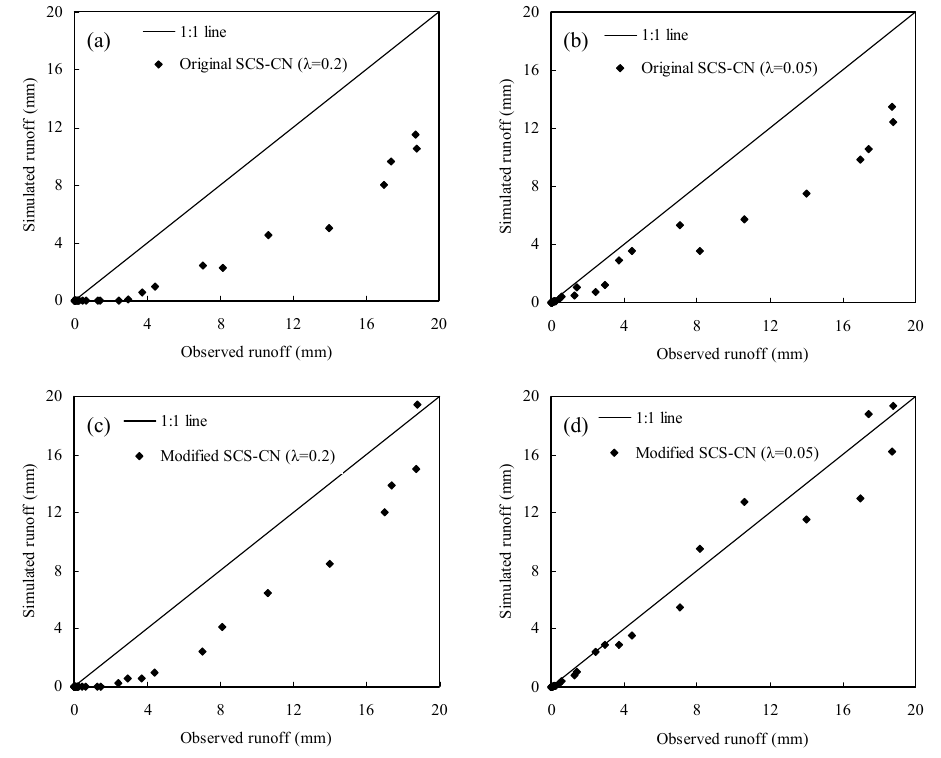
Fig. 4. Comparison between observed and predicted event runoff using (a) Original SCS-CN ( λ =0.2), (b) Original SCS-CN ( λ =0.05), (c) Modified SCS-CN ( λ =0.2) and (d) Modified SCS-CN ( λ =0.05) models for Group 2 runoff plots